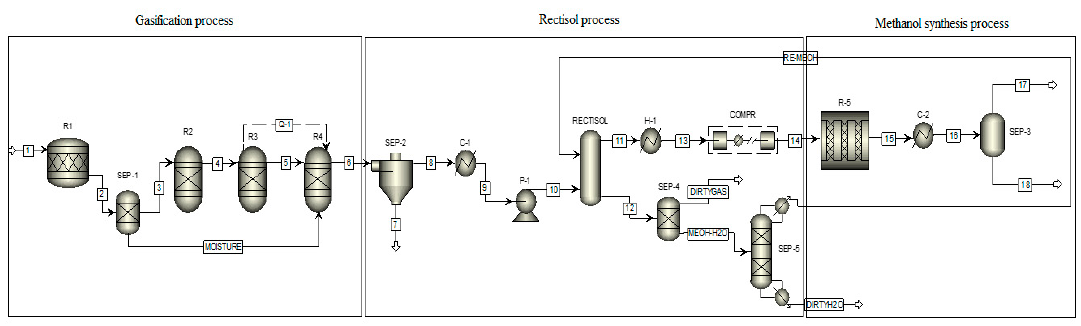
Figure 1. Process flow diagram of the Aspen Plus model for methanol synthesis via pyrolysis oil gasification.